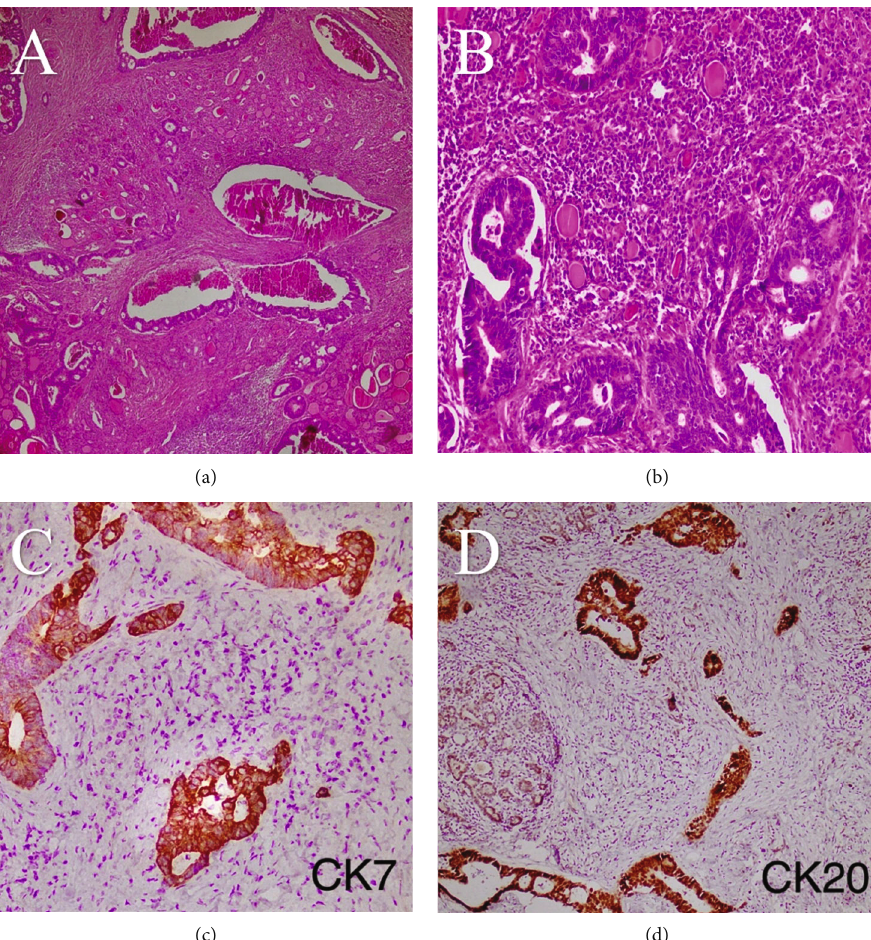
Figure 4: Microscopic sections show metastatic glands of colon adenocarcinoma, in fi ltrating between thyroid follicles: (a) H&E × 40 and (b) (H&E × 200). The metastatic gland shows immunoreactivity for CK7 (c) and CK20 (d).